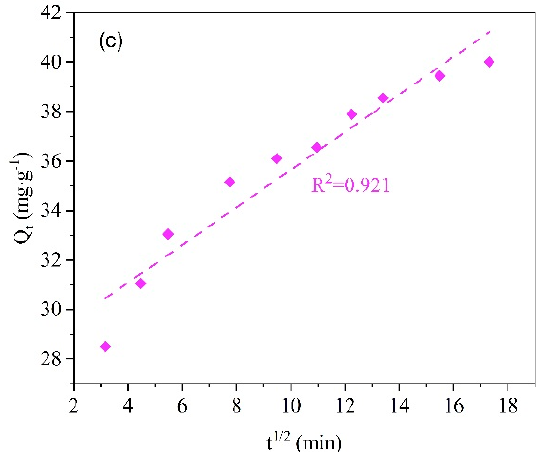
Figure 8. Linear fitting of pseudo-first-order ( a ), pseudo-second-order ( b ) and intraparticle diffusion ( c ) kinetic models for the lead ions adsorption on pristine slag. Table 10. Kinetic parameters for the adsorption of lead ions on pristine slag. Pseudo-First-Order